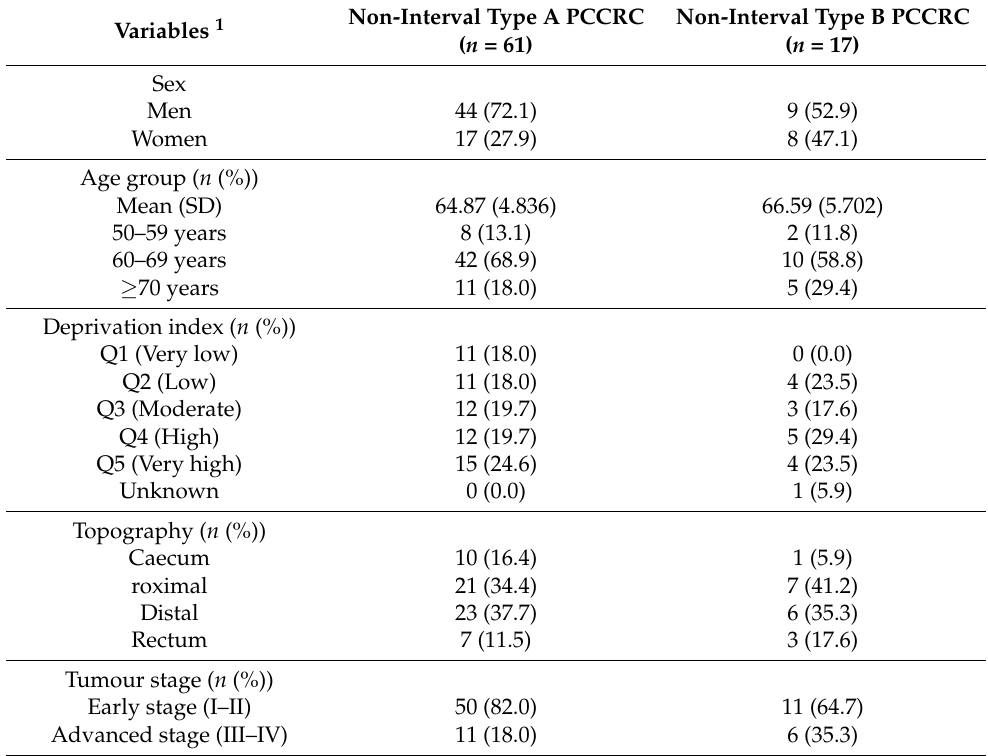
Table 4. Characteristics of non-interval type A PCCRC and non-interval type B PCCRC.